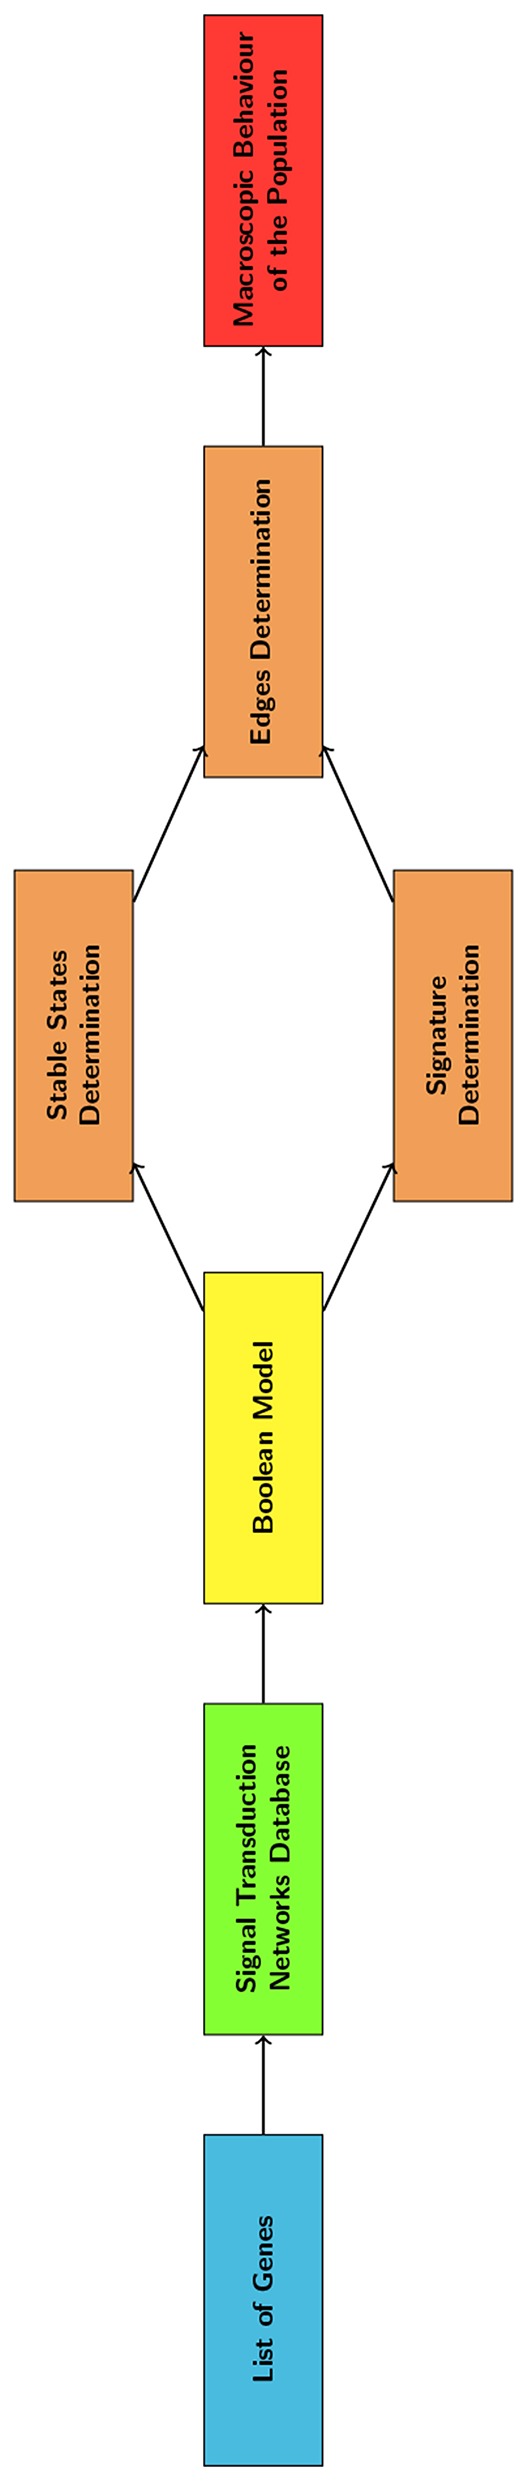
Flowchart describing the main steps of the computational method here described.